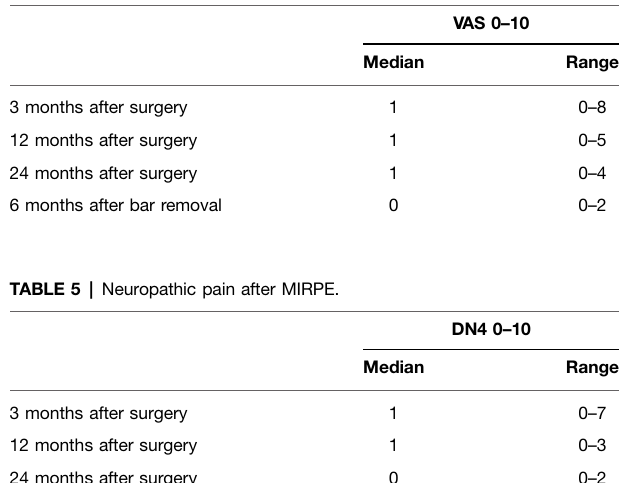
TABLE 4 | Pain intensity after MIRPE.